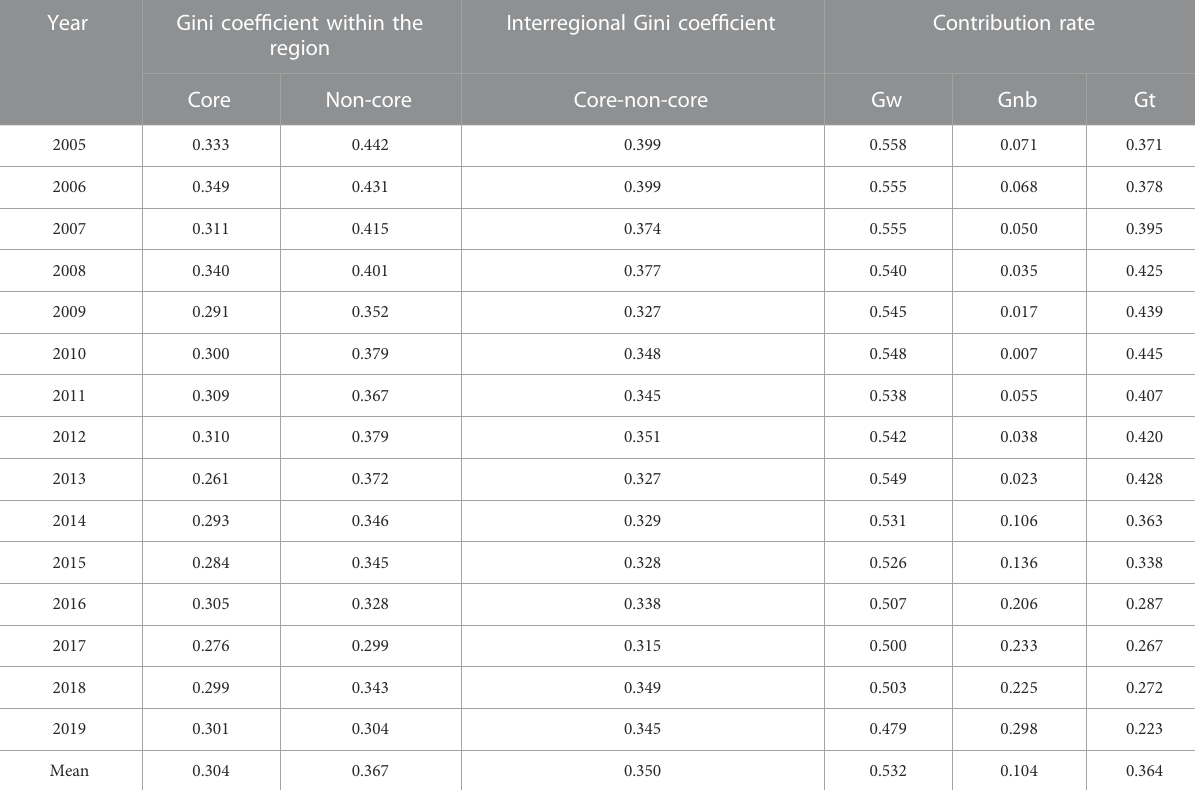
TABLE 4 Disparities in ULGUE in the Yangtze river economic belt